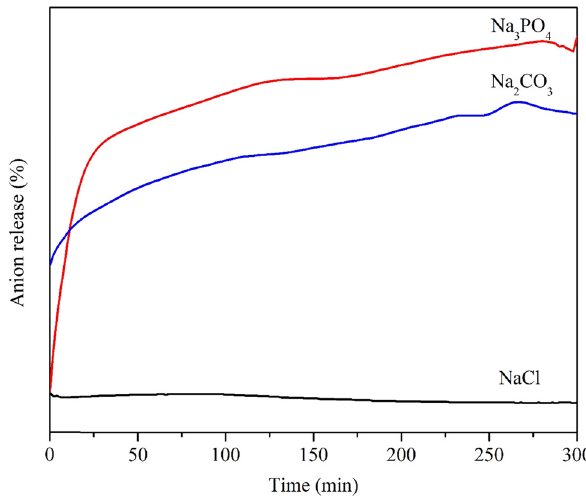
Figure 6: Release pro fi le of MCPA from CaAl LDH in various aqueous media.